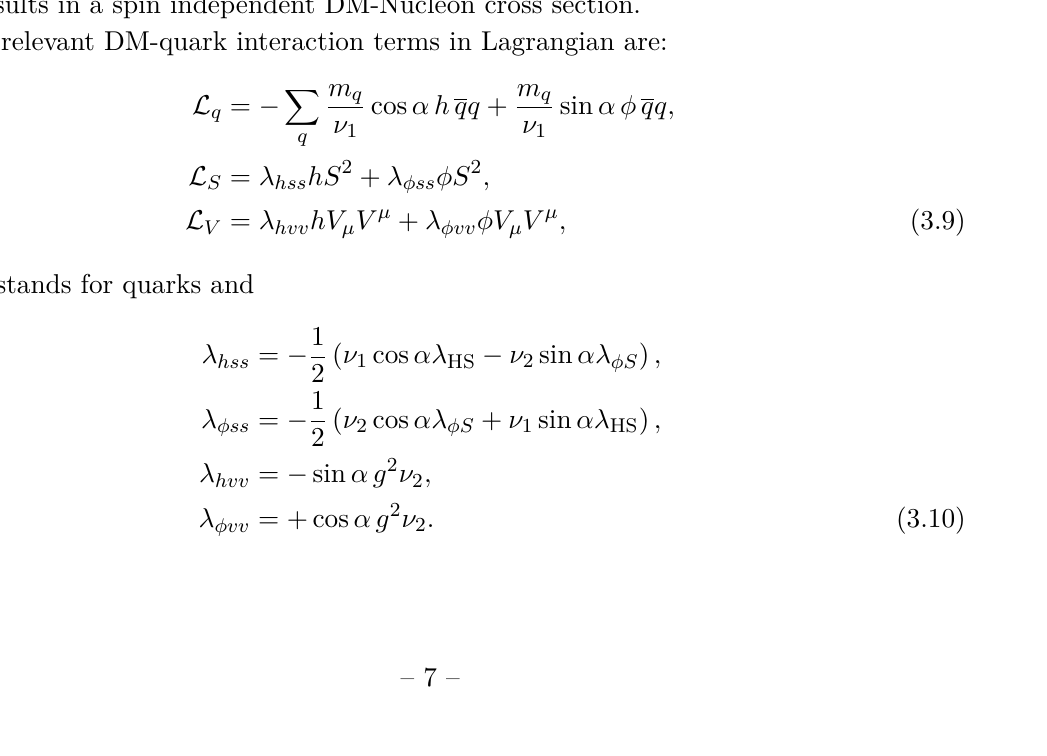
Figure 4. DM-quark interaction via t channel exchanges of the h and ϕ